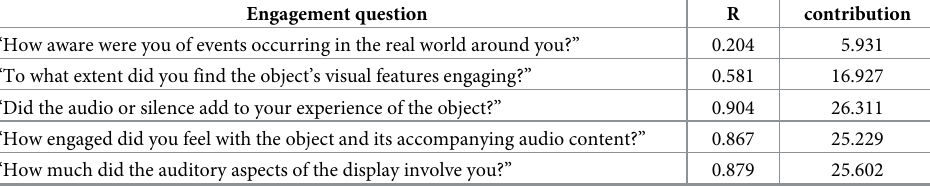
Table 4. Relationships between each engagement question and PC1. “R” denotes the Pearson correlation between each question and PC1, while “contribution” denotes the % of relative contribution of each individual question to the principal component.